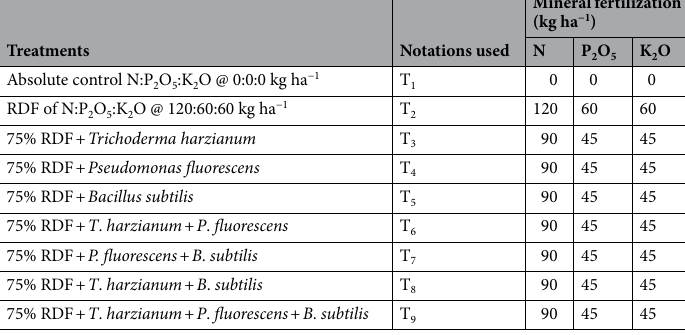
Table 7. Details of treatment combinations applied during the